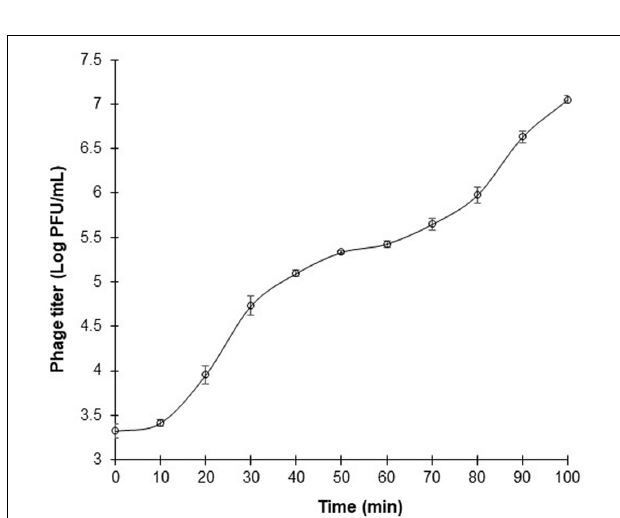
FIGURE 4 | One-step growth curve of phage (cid:56) Ent infecting Salmonella Thompson at MOI 0.01 in cucumber juice at 37 ◦ C. The latent period is approximately 10 min, and the burst size is about 100 phage particles per infected cell. Error bars indicate the standard error of the mean.